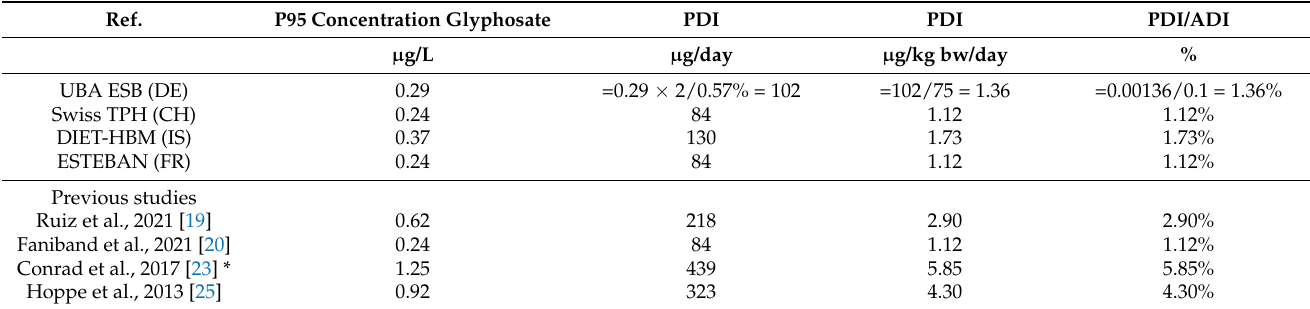
Table 4. Risk assessment of glyphosate (Gly) in adults of the general population based on HBM data (detection of Gly and AMPA with mass